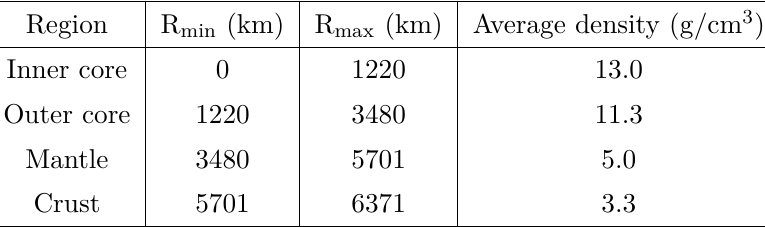
( R ) is the radius at which a given layer min max